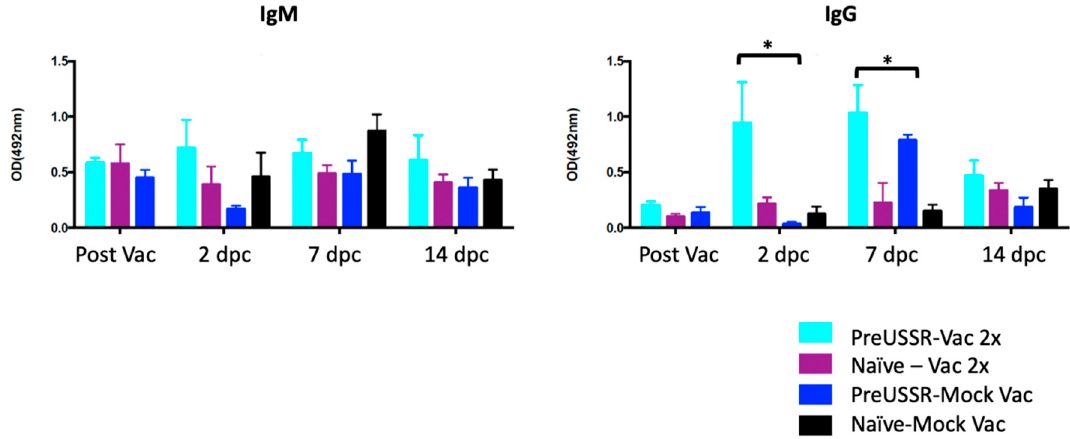
Figure 7. Increased virus-specific IgG isotype serum antibody titers following challenge in the preimmune-vaccinated ferrets compared to naïve-vaccinated ferrets. Isotype ELISAs were performed using sera collected from each group throughout the time course to quantify the circulating virus-specific IgG and IgM antibodies. Only time points post vaccination and challenge are shown Post Vaccination, Day 2 p c, Day 7 p c, and Day 14 p c. A Student’s t -test was conducted to compare with results on Day 0, * p < 0.05.